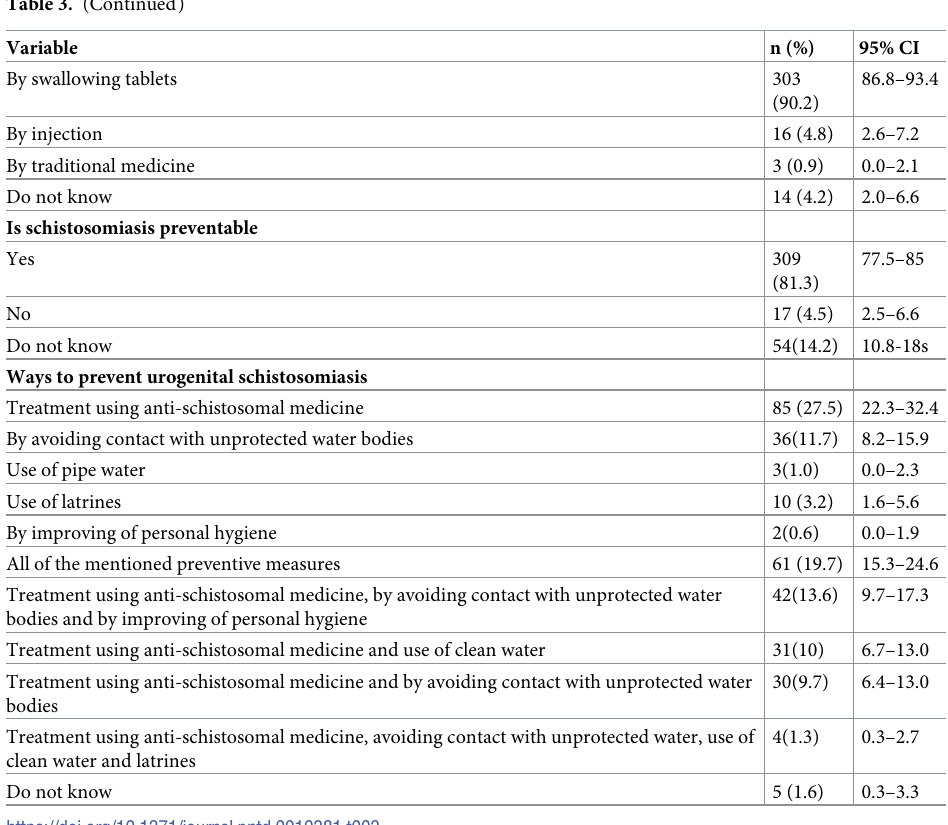
infection through swimming/playing in the water sources (60.5%). In terms of prevention, about one-third of the parents/guardians (34.3%) agreed that snail control would prevent uro- genital schistosomiasis transmission, and the use of protective waterproof clothes and gumboots when in contact with water, could prevent the acquisition of the disease (49.1%) (Fig 3). Influence of socio-demographic characteristics on the attitudes and practices on urogenital schistosomiasis among the study participants The age group, > 56 years, had higher participants with positive attitudes (70%) and appropri- ate practices (100%) for urogenital schistosomiasis compared to the remaining age groups. Also, the group of parents/guardians who never attended school had a high number of partici- pants with negative attitudes (47.3%) and inappropriate practices (44.5%) toward urogenital schistosomiasis, compared to other education levels. There was a statistically significant associ- ation between the level of education of the parents/guardians and their attitudes (p = 0.029) and practices (p = 0.042) towards urogenital schistosomiasis (Table 5). Of the 385 parents/ guardians who participated in this study, 156 (40.5%) had negative attitudes towards urogeni- tal schistosomiasis, while 229 (59.5%) had positive attitudes. In addition, a total of 132 (34.3%) parents/guardians had inappropriate practices towards urogenital schistosomiasis, and the remaining 253 (65.7%) had appropriate